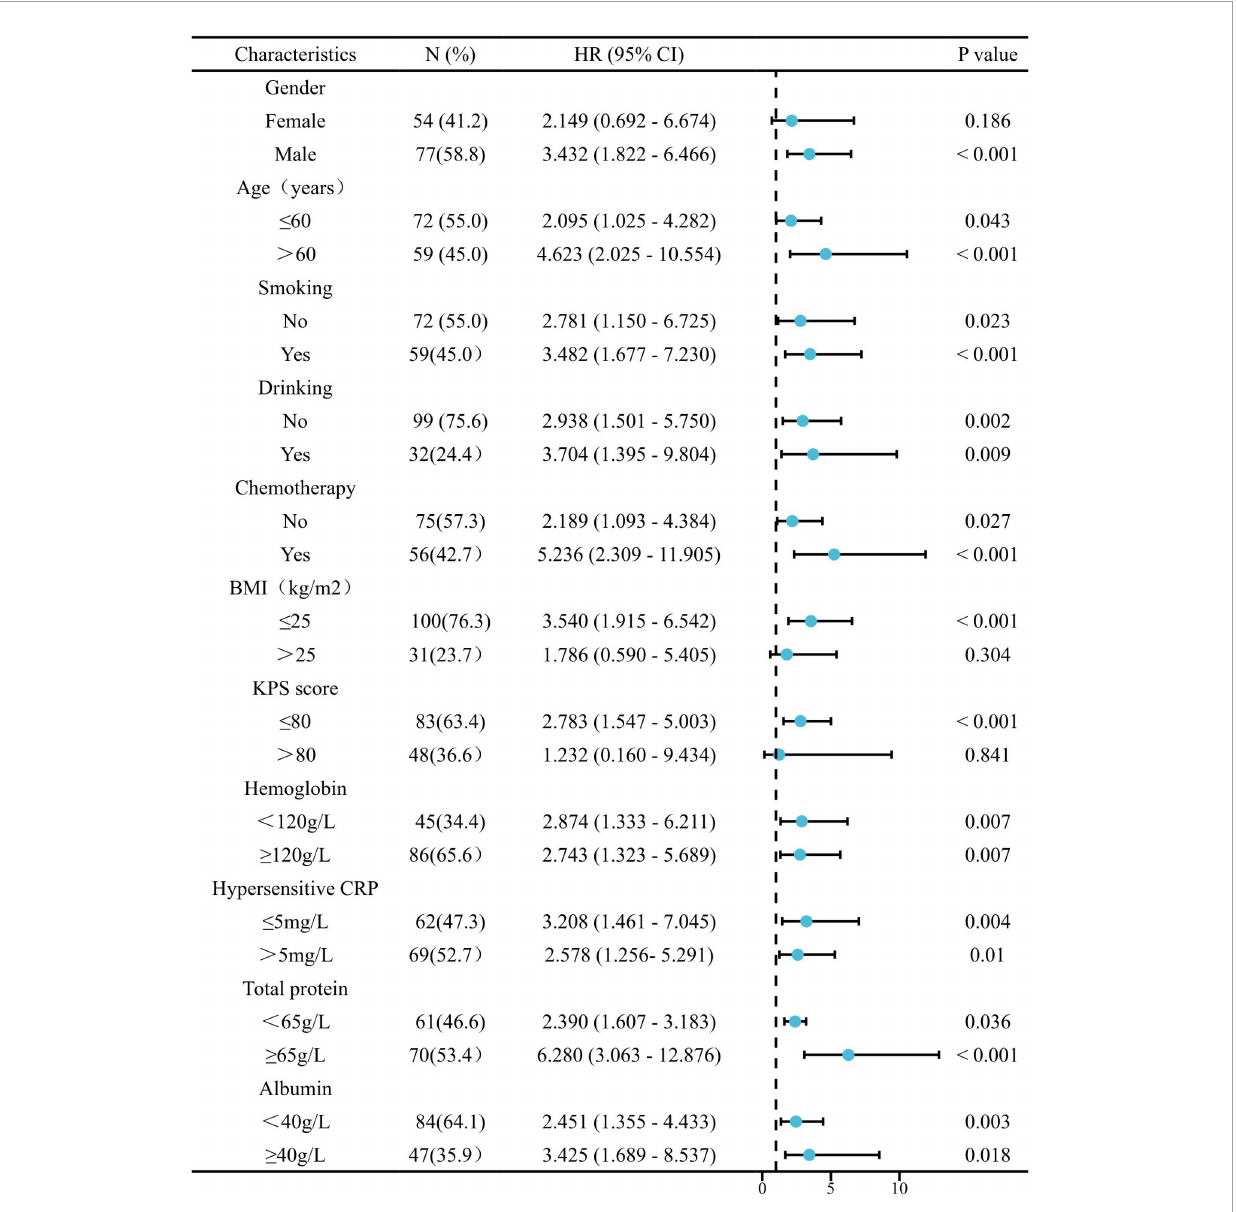
only sarcopenia [hazard ratio (HR): 2.187, 95% confidence interval (CI): 1.230–3.891, p = 0.008; Table 2 ] and albumin [hazard ratio (HR): 0.921, 95% confidence interval (CI): 0.860–0.987, p = 0.019; Table 2 ] as strong independent predictors of OS. Univariate and multivariate Cox regression analyses of both the EGFR-TKI- treated and ICI-treated cohorts confirmed that sarcopenia was an independent negative factor for OS (EGFR-TKI-treated group, HR: 2.806, 95% CI: 1.304–6.037, p = 0.008; Supplementary Table 3 ; ICI-treated group, HR: 2.155, 95% CI: 1.107–4.484, p = 0.028; Supplementary Table 4 ). Univariate Cox regression analysis revealed that BMI, sarcopenia, KPS score, hCRP level, and albumin level were significant prognostic factors for PFS (all p < 0.05; Table 3 ).